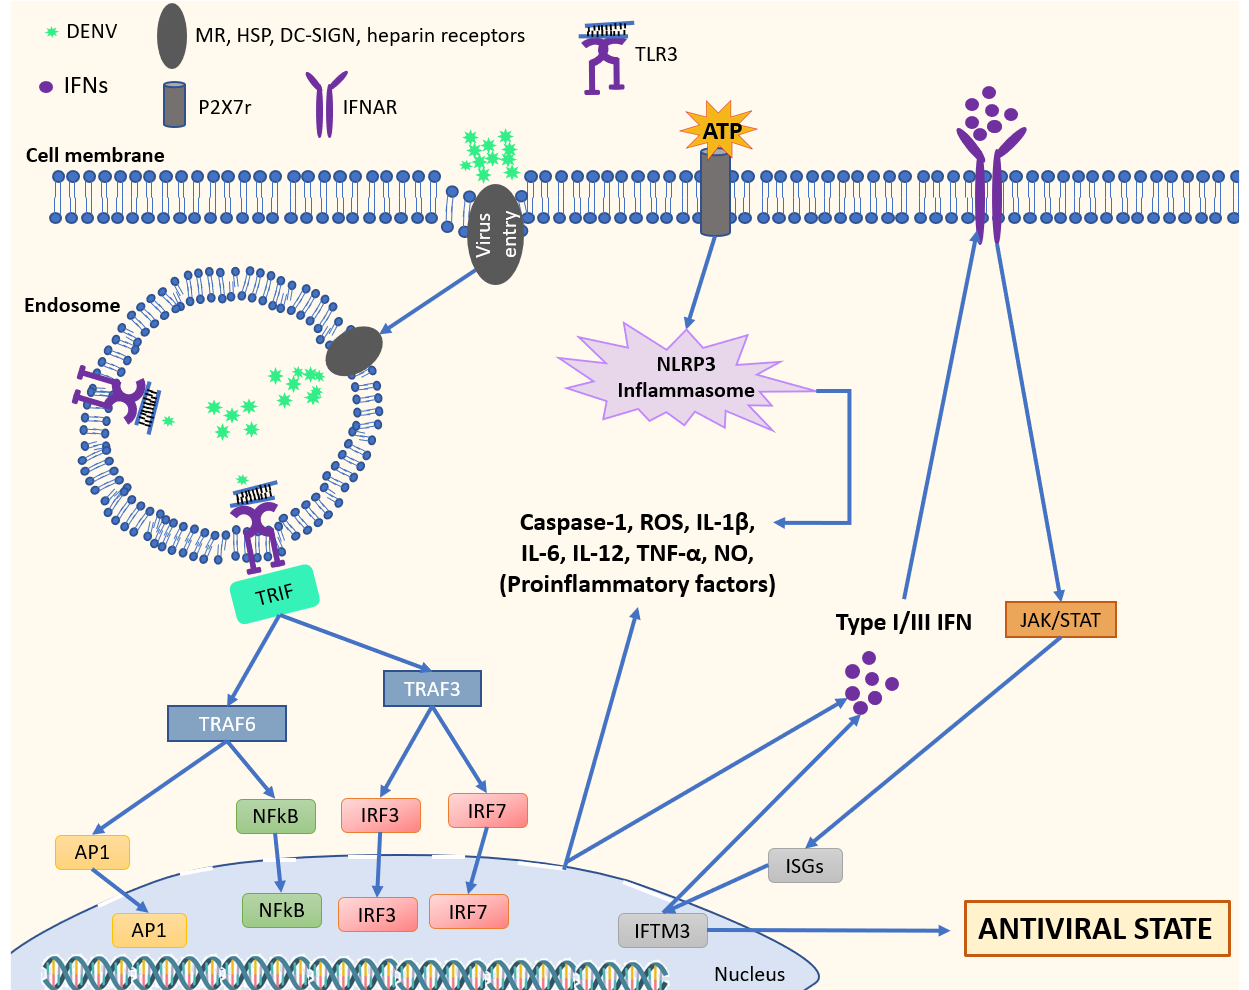
Figure 2. Antiviral state by activation of nucleic acid sensing by TLR3. TLR3 can recognize dsRNA as consequence of DENV infection. TLR3 activation stimulates production of proinflammatory factors and IFNs through transcription factors such as AP1, NFkB and IRF3/7. Activation of IFNAR by IFNs results in the transcription of hundreds of types IFN I and III and ISGs (via JAK/STAT) such as IFITM3 that promote IFN release in the endosomal compartment. During DENV infection, release of DAMPs and soluble mediators such as ATP and TNF- α are recognized by several cellular receptors such as P2X7r (ATP), triggering inflammasome assembly and activation. Consequently, capase-1, IL-1 β , ROS and TFAM are produced and play roles in antiviral response and mitochondrial DNA releasement that may result in proinflammatory state and cytokine storm. Abbreviations: mannose receptor- MN, heat shock protein-HSP, dendritic cell-specific intercellu-lar adhesion molecule-3 grabbing non-integrin-DC-SIGN, interferon-induced transmembrane protein 3-IFITM3, Interferon Stimulated Genes-ISGs, Tumor necrosis factor receptor-associated factor-TRAF, reactive oxygen species-ROS, interferon regulatory factor-IRF, TIR-domain-containing adaptor protein inducing interferon- β (IFN β ) -TRIF, transcription factor A